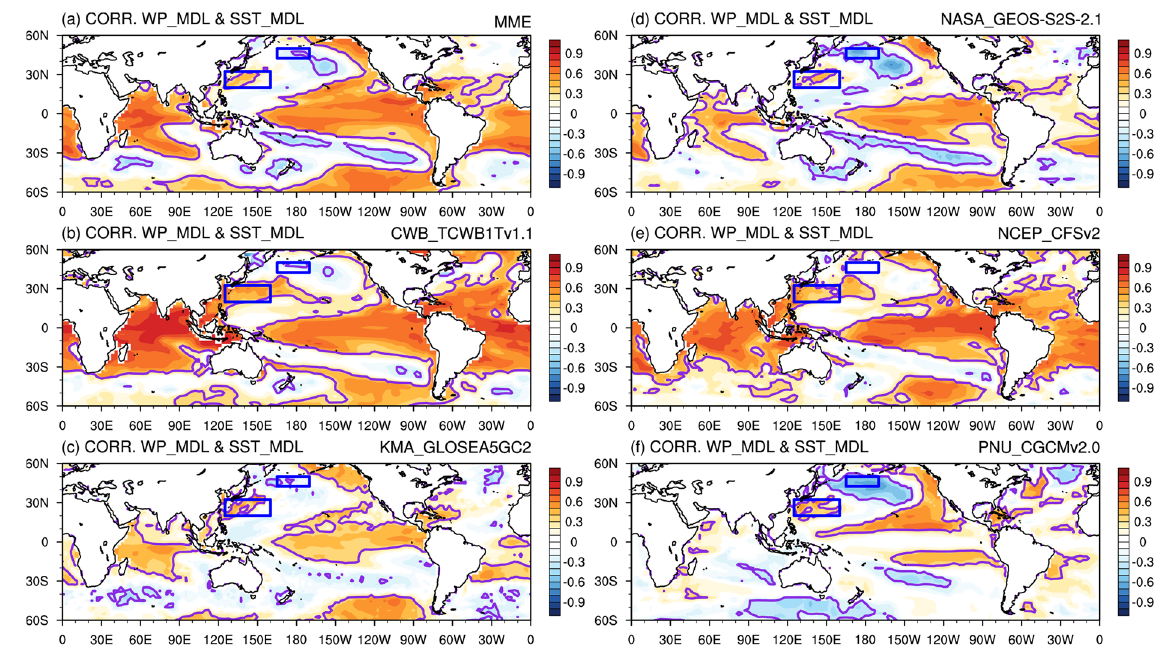
Figure 8. Correlation patterns between Z500 and the WP index predicted by the ( a ) MME ( b – f ) and individual models for the entire series. Blue boxes enclose the areas of SST averaging used for the estimation of the NWP index. Significant at the 95% confidence level values are enclosed by a thick line.